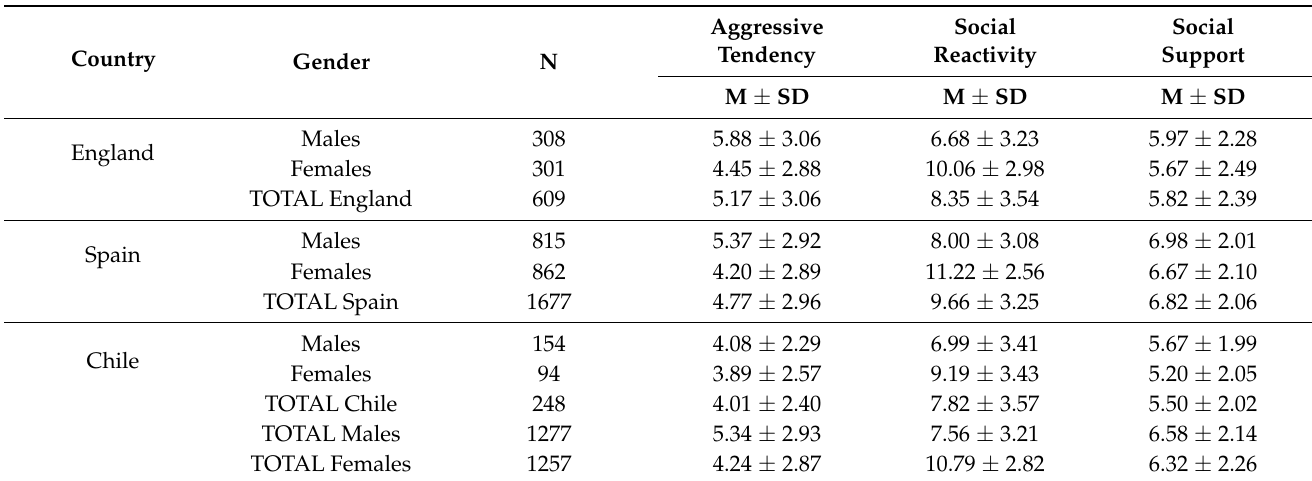
Table 3. Descriptive statistics.